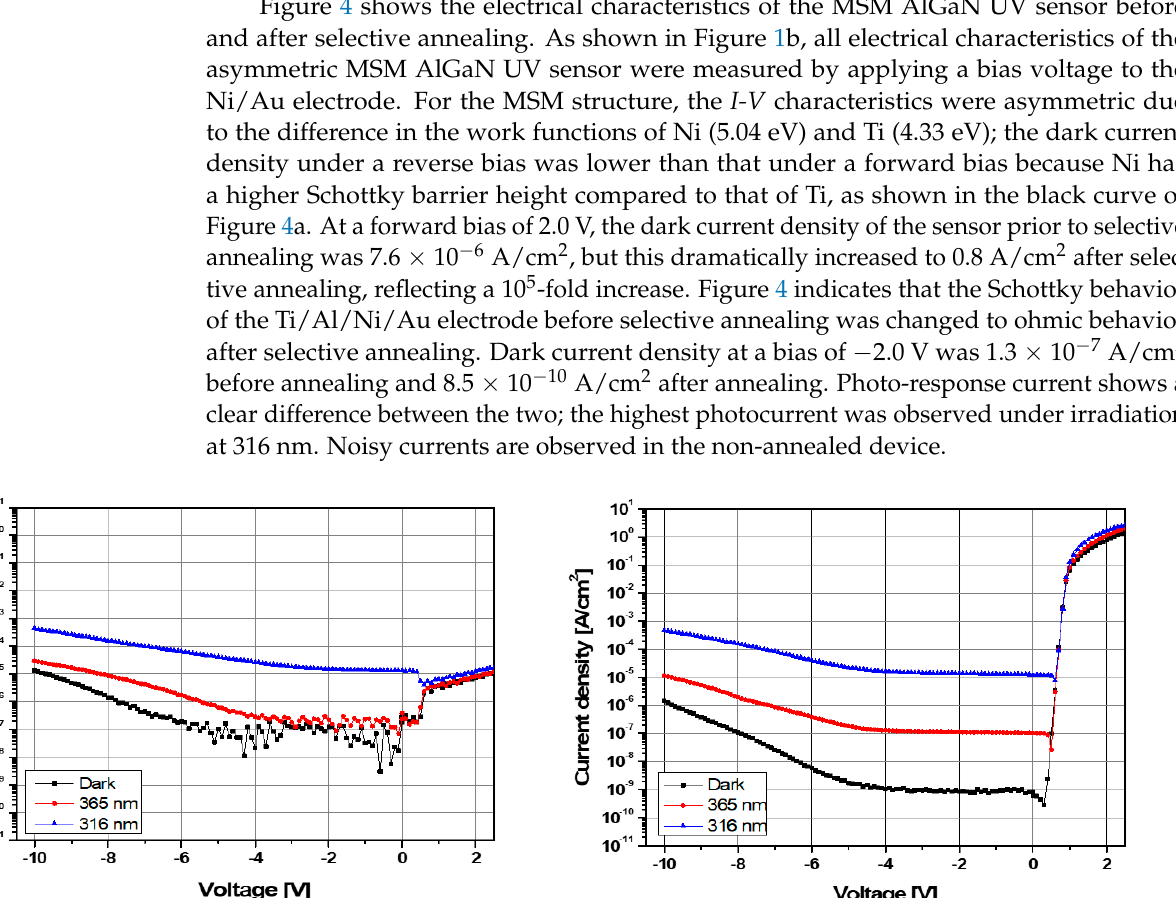
Figure 3. Images magnified 90x using a photomicroscope of MS TECH’s MST-8000C probe station: top views of an asym- metric MSM AlGaN UV sensor ( a ) before and ( b ) after selective annealing (annealed region is marked with dotted box).